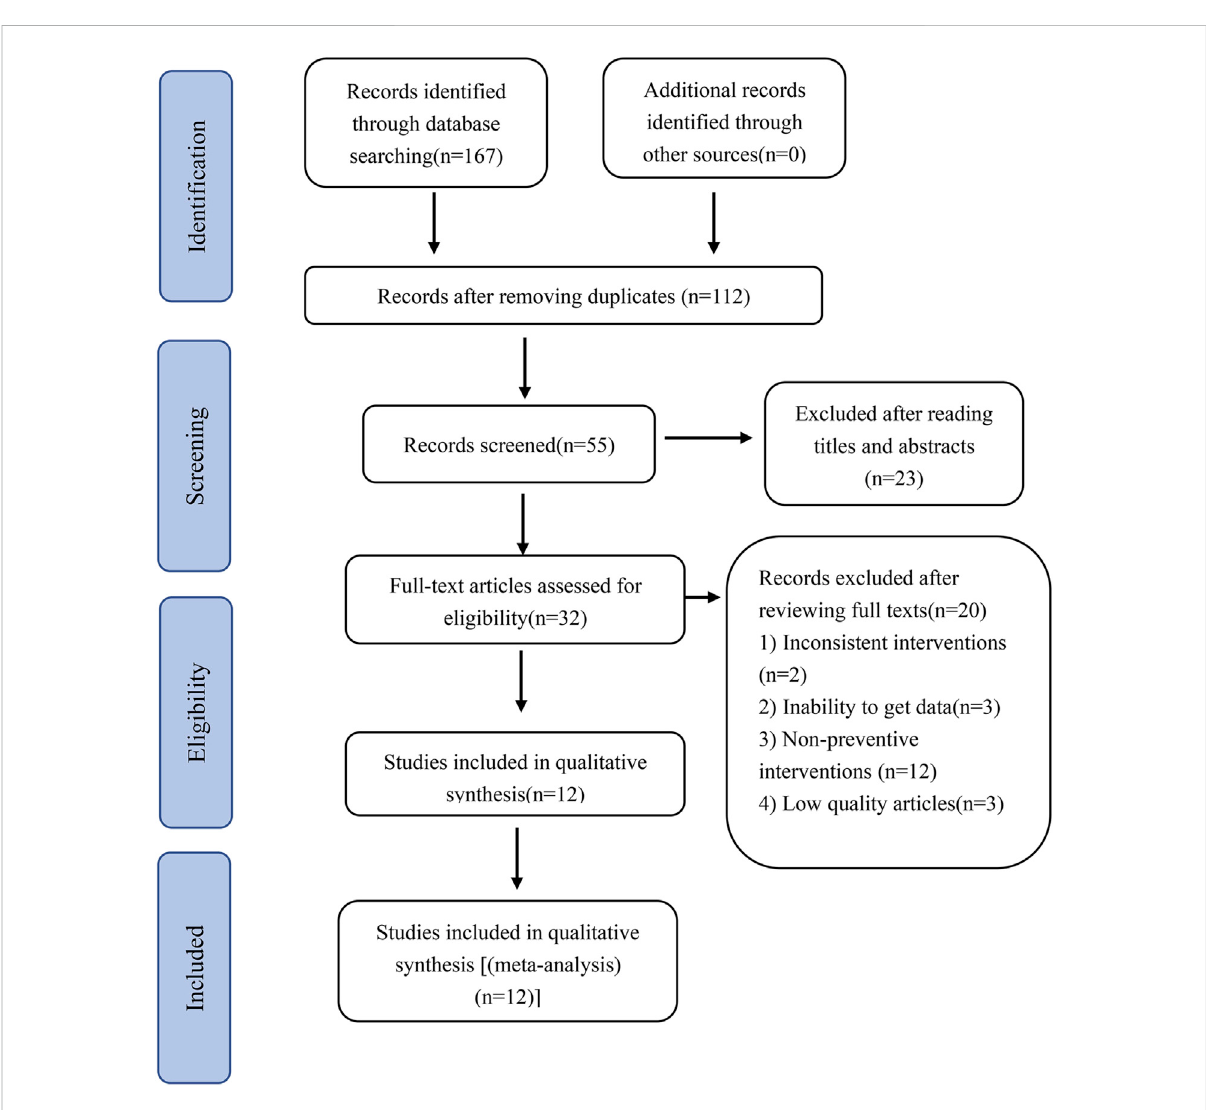
FIGURE 1 PRISMA fl ow chart of the article fi ltering